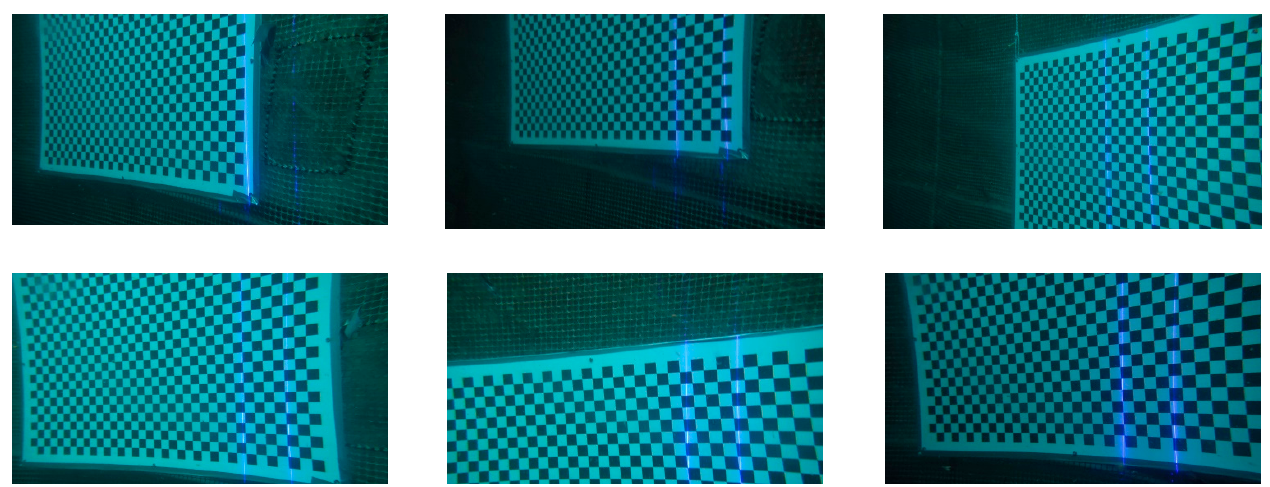
Figure 4. Example of calibration images for the camera-laser 3D measurement. The laser lines can be seen in the left part of the checker board.